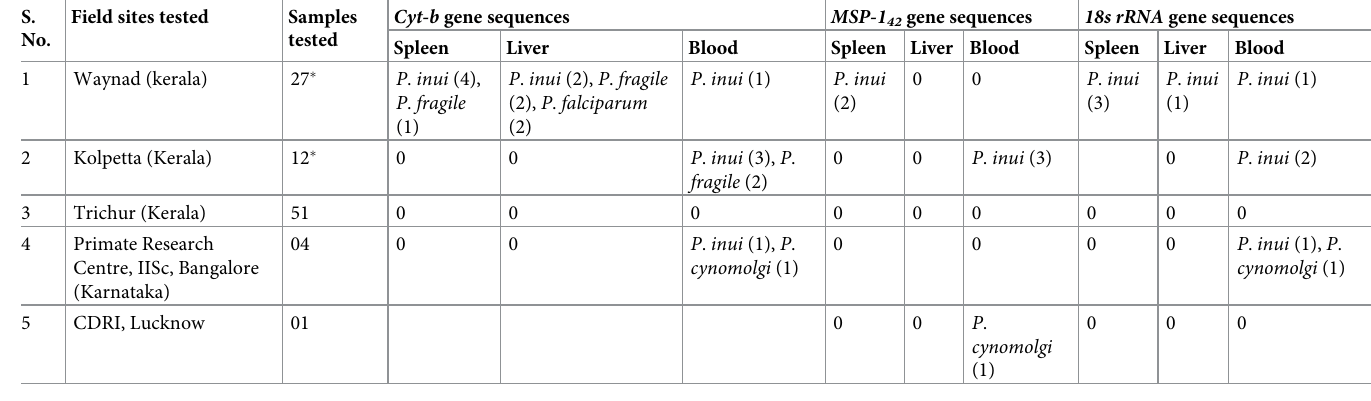
Table 2. Details of Plasmodium species detected using blood and tissue samples of M . radiata species. S. Field sites No.